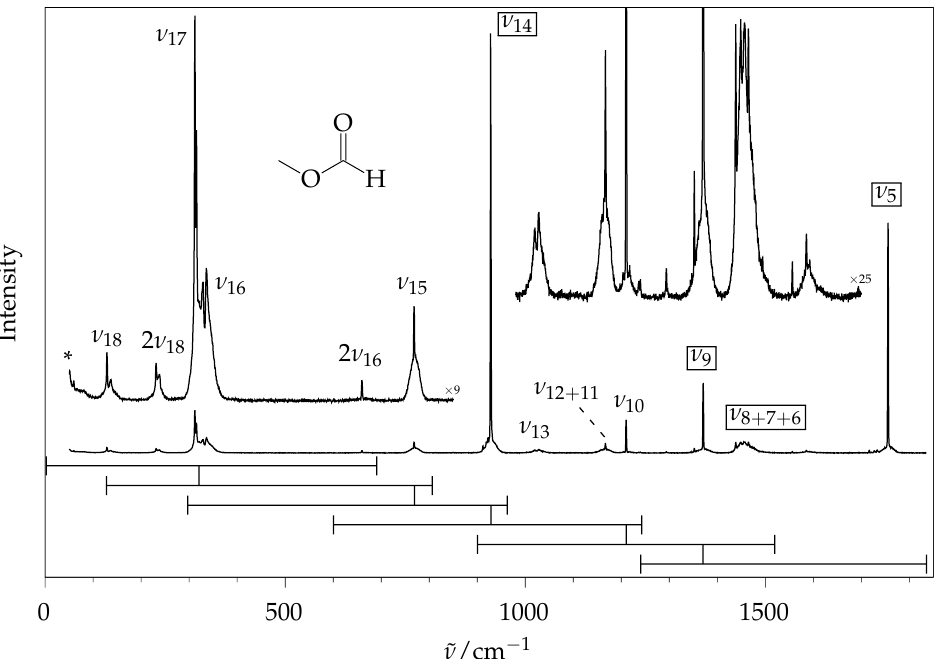
Figure 4. Experimental jet spectrum of methyl methanoate, constructed from six overlapping segments (horizontal bars, intensity matching at the vertical connection lines). * marks air impurities, any signal < 50cm − 1 is distorted by a Rayleigh edge filter. The band labels ν 5 see Table 1 for the associated dominant vibrational character and symmetry. Signals that are used for normalisation in Table 1 are framed.